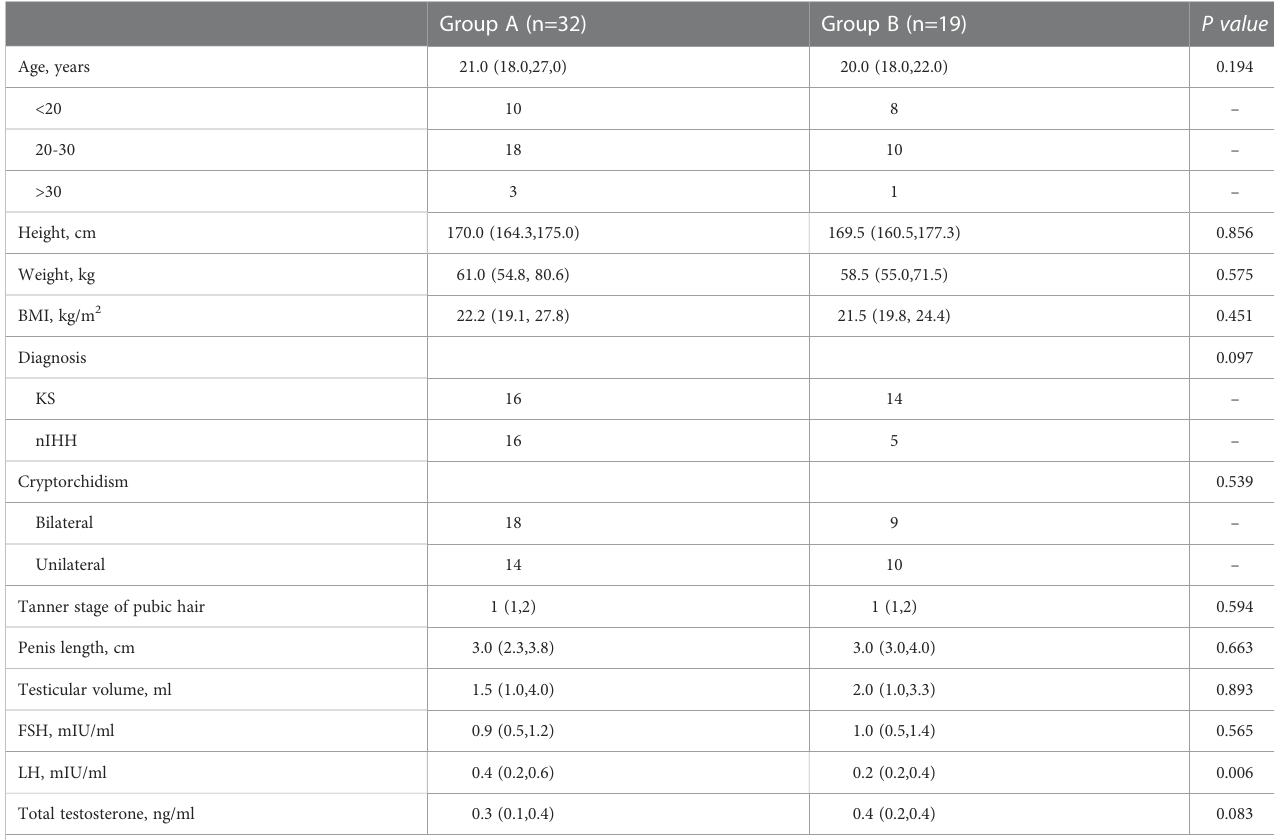
TABLE 1 Basic characteristics of the IHH patients with cryptorchidism in the two groups.